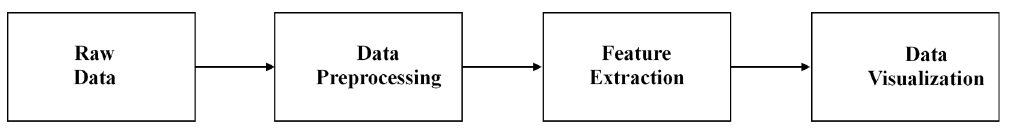
Figure 3. Data analytics pipeline.